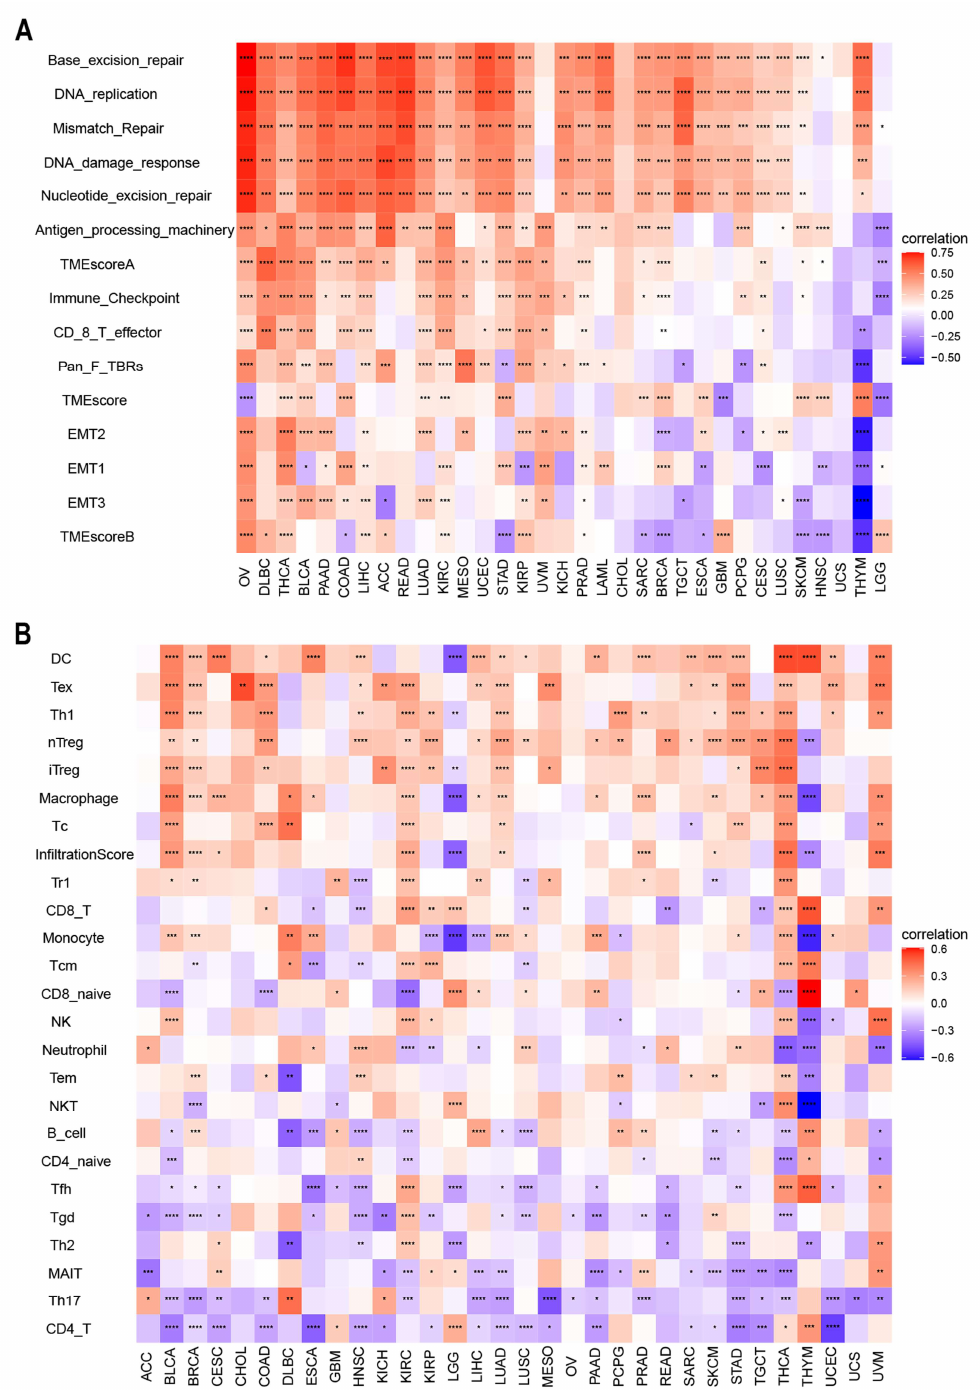
Figure 7. ( A ) Heatmaps to show the relationship between ACOT7 expression and tumor microenvi- ronment (TME); ( B ) heatmaps to show the relationship between ACOT7 expression and immune cell infiltration. * p < 0.05, ** p < 0.01, *** p < 0.001, **** p <